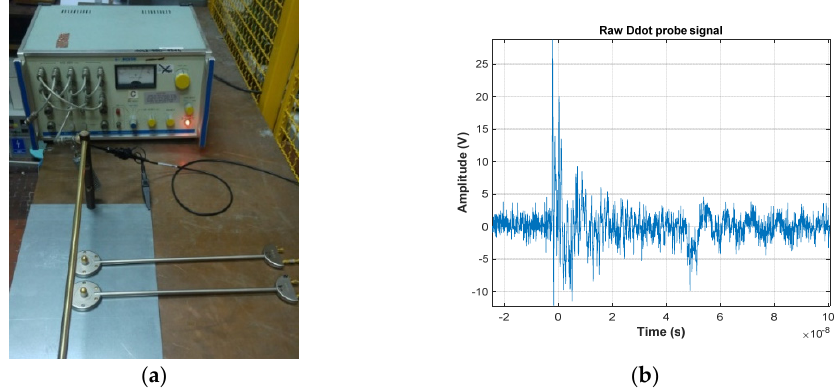
Figure 4. Measurement setup ( a ), raw signal from electric field probes ( b ). Equipment used is the same as in the Figure 3 setup. Additionally, there is a pulse generator NOISE INS-420 shown in the picture. Figure 4b uses original oscilloscope time scaling. It’s a convenient way to differentiate pre and post trigger signal